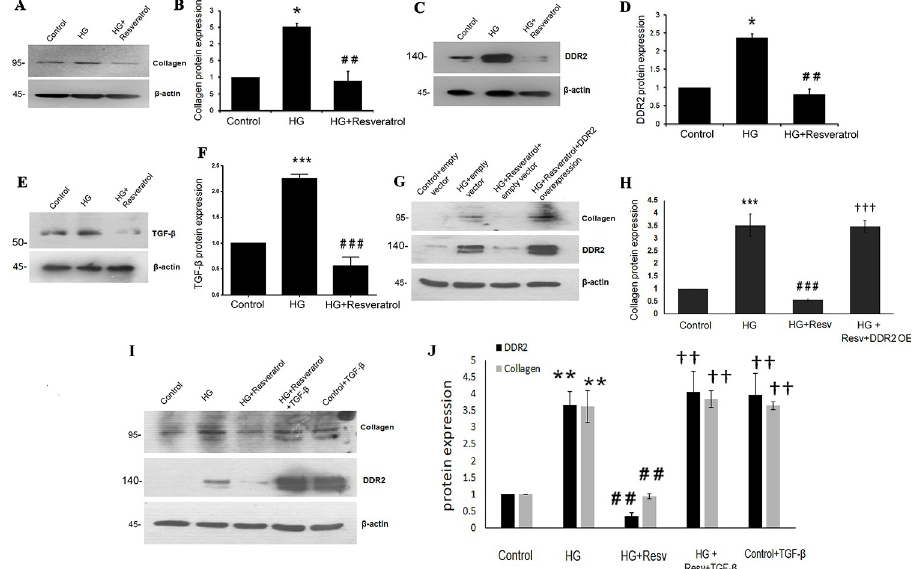
Fig 5. Resveratrol prevents HG-induced collagen type I and DDR2 in vascular adventitial fibroblasts. (A-F) Sub- confluent quiescent cultures of vascular adventitial fibroblasts in M199 were pre-treated with 50 μ M resveratrol for 1 h and subsequently with HG for 12 h. Protein was isolated at 12 h post-HG treatment and subjected to western blot analysis for detection of: ( A and B) Collagen type I alpha 1; � p < 0.05 vs. control, ## p < 0.01 vs. HG (One-way ANOVA p < 0.05), and ( C and D) DDR2; � p < 0.05 vs. control, ## p < 0.01 vs. HG (One-way ANOVA p < 0.05). (E and F) TGF- β 1; ��� p < 0.001 vs. control, ### p < 0.001 vs. HG (One-way ANOVA p < 0.05). β -actin was used